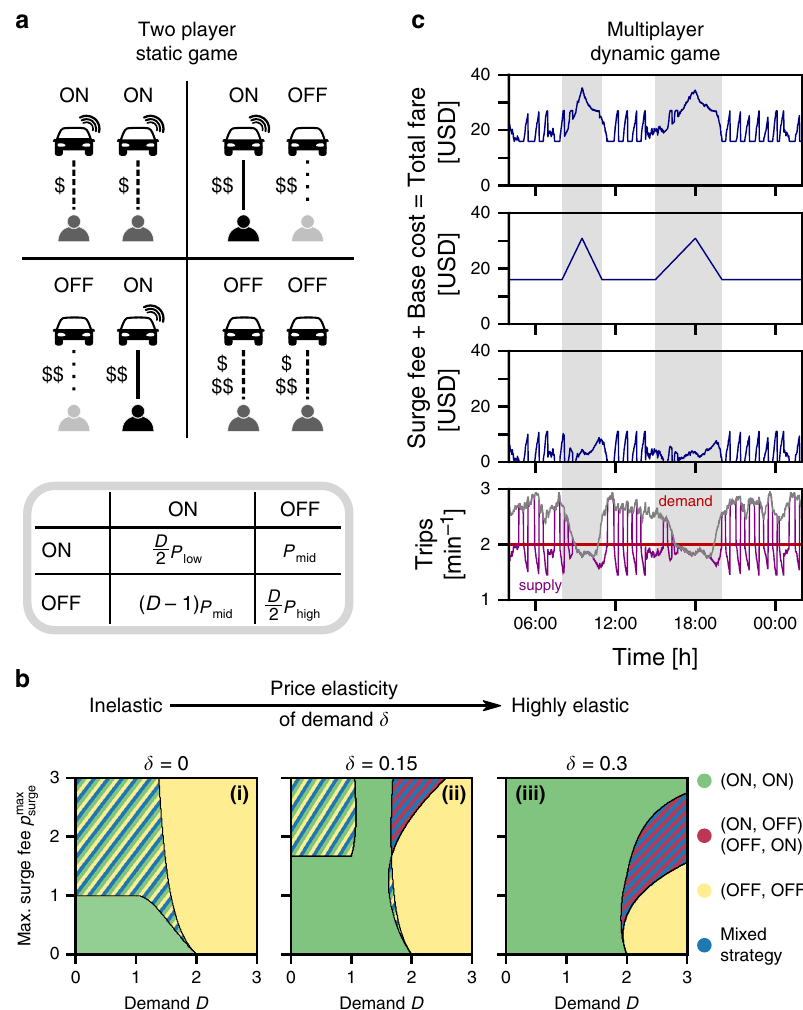
Fig. 2 Incentive structure in dynamic pricing. a A two player game captures the fundamental incentives for drivers. Both drivers compete for a fi xed average number of customers 1 ≤ D ≤ 2. The drivers may choose to temporarily switch off their apps to induce an arti fi cial supply shortage and additional surge fees (see “ Methods ” section). If both drivers keep their apps on, both earn p low ($) with probability D /2 (panel a , top left). If one driver switches their app off, the total fare increases to p mid ($$). However, the other driver exploits their fi rst-mover advantage to secure a customer, earning guaranteed p mid , while the of fl ine driver only earns ( D − 1) p mid from the remaining demand (panel a , top right and bottom left). If both drivers switch off their apps, they induce a larger supply shortage and thus a larger surge fee, resulting in the total fare p high ($$$). Both drivers again share the demand equally when they go back online (panel a , bottom right). b Phase diagram of the resulting Nash equilibria. (i) If the demand is suf fi ciently large, the game is trivial and both drivers always go of fl ine, triggering anomalous supply shortages (orange). At low demand the game becomes a prisoner ’ s dilemma 21 and both drivers remain online (green) or stag hunt 22 (hatched region with multiple coexisting Nash equilibria). (ii) and (iii) As the demand becomes more elastic and decreases as the price increases [Eq. (4)], drivers switching off their app risk missing out on a customer completely and the parameter range promoting arti fi cial price surges becomes smaller (orange). Drivers are more likely to both remain online (green). At high demand and high surge fee, partial supply shortages emerge as equilibrium states where only one of the two drivers goes of fl ine (red/blue hatched). These results are robust for nonlinear demand response (see Supplementary Figs. 18 and 19). c A dynamic game with multiple drivers (see “ Methods ” section and Supplementary Note 3) qualitatively reproduces the observed dynamics (compare DCA, Fig. 1b): Sustained non-zero surge fees occur during commuting hours with high base cost (gray). During non-commuting hours, drivers cooperate to induce arti fi cial supply shortages to optimize their collective pro fi